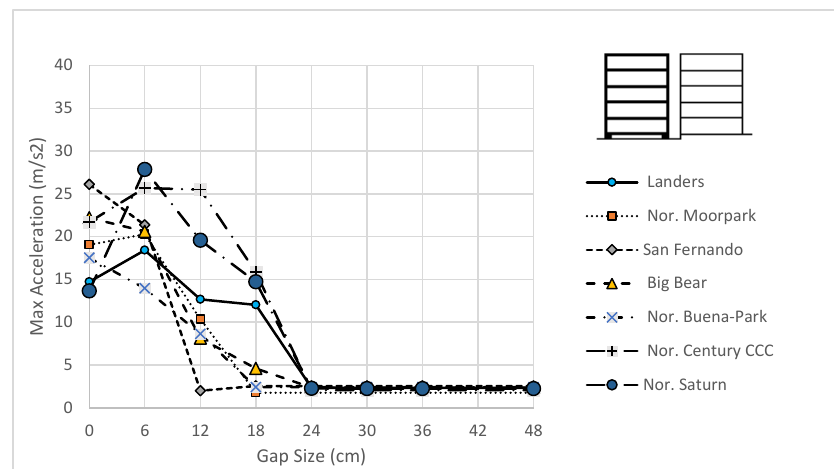
Figure 3. Peak accelerations of the 5th story of the base-isolated building with respect to different gap sizes for the first configuration under various earthquakes.